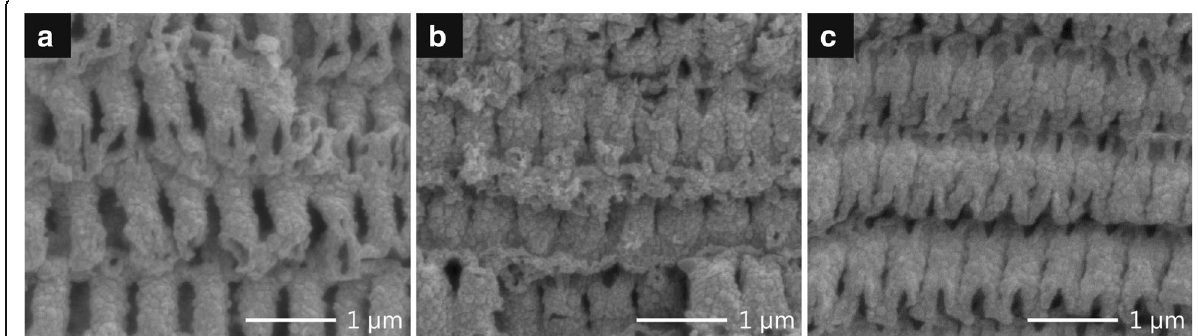
Fig. 4 Cross-sectional SEM images with higher magnification of nanoshell-based 3D inverse structures. The infiltration process was conducted with different cycle numbers from four to six ( a – c )